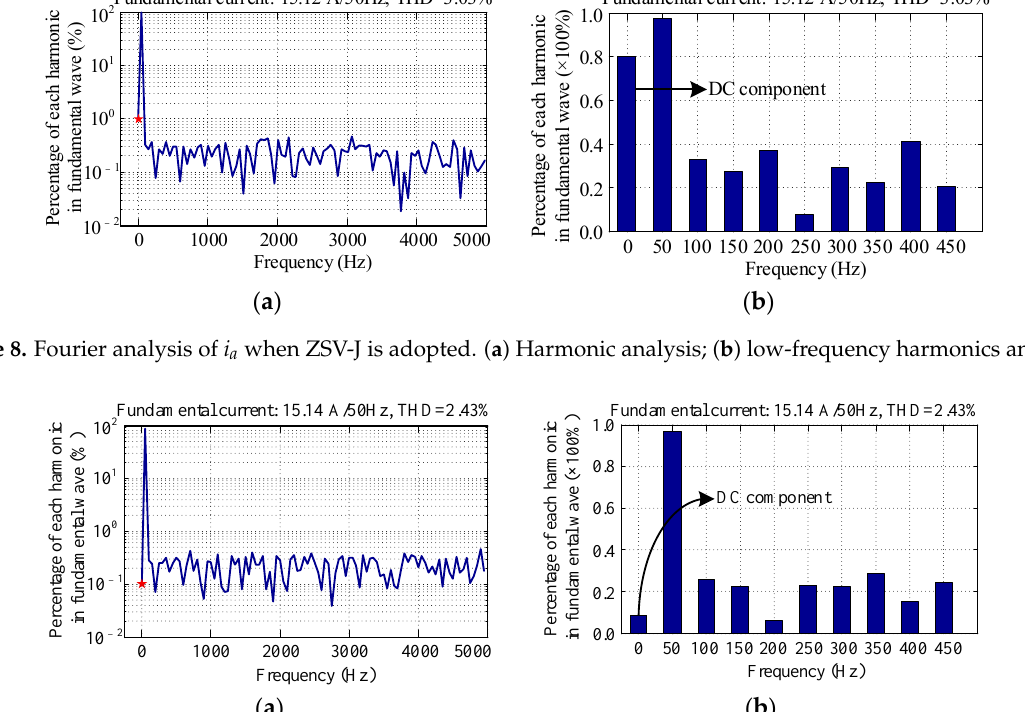
( b ) Figure 12. Performance comparisons of the two NPV control strategies when the two loads are unequal. ( a ) ZSV-J; ( b ) the proposed NPV control strategy.